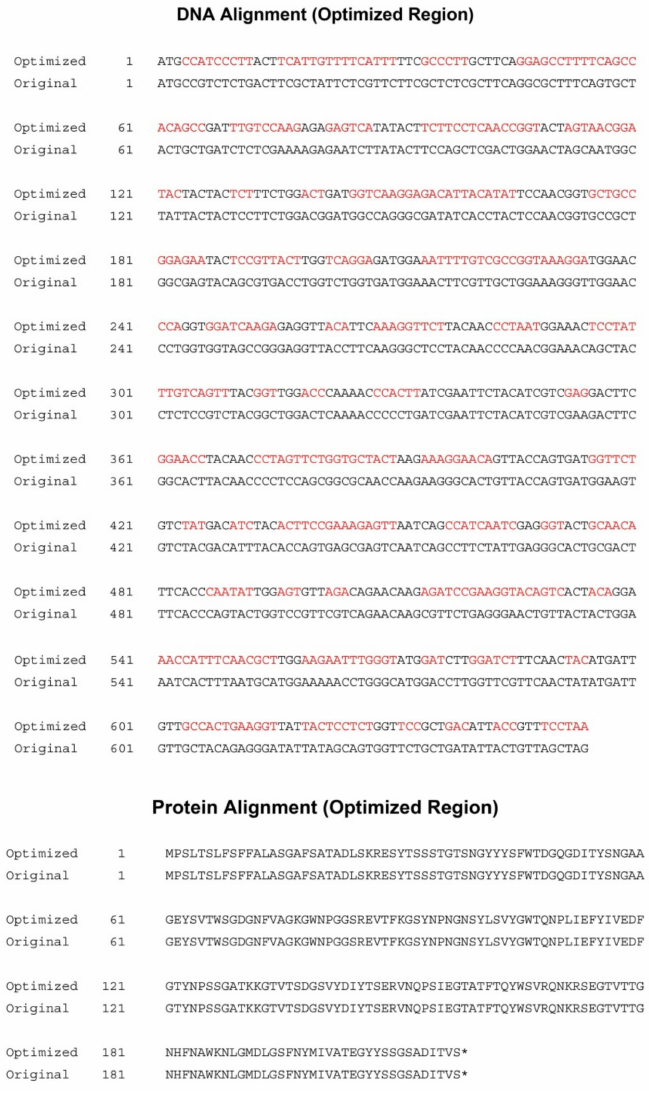
Figure 1. DNA alignment and protein alignment of the original and codon-optimized (for expression in P. pastoris ) xynA gene from P. citrinum FERM